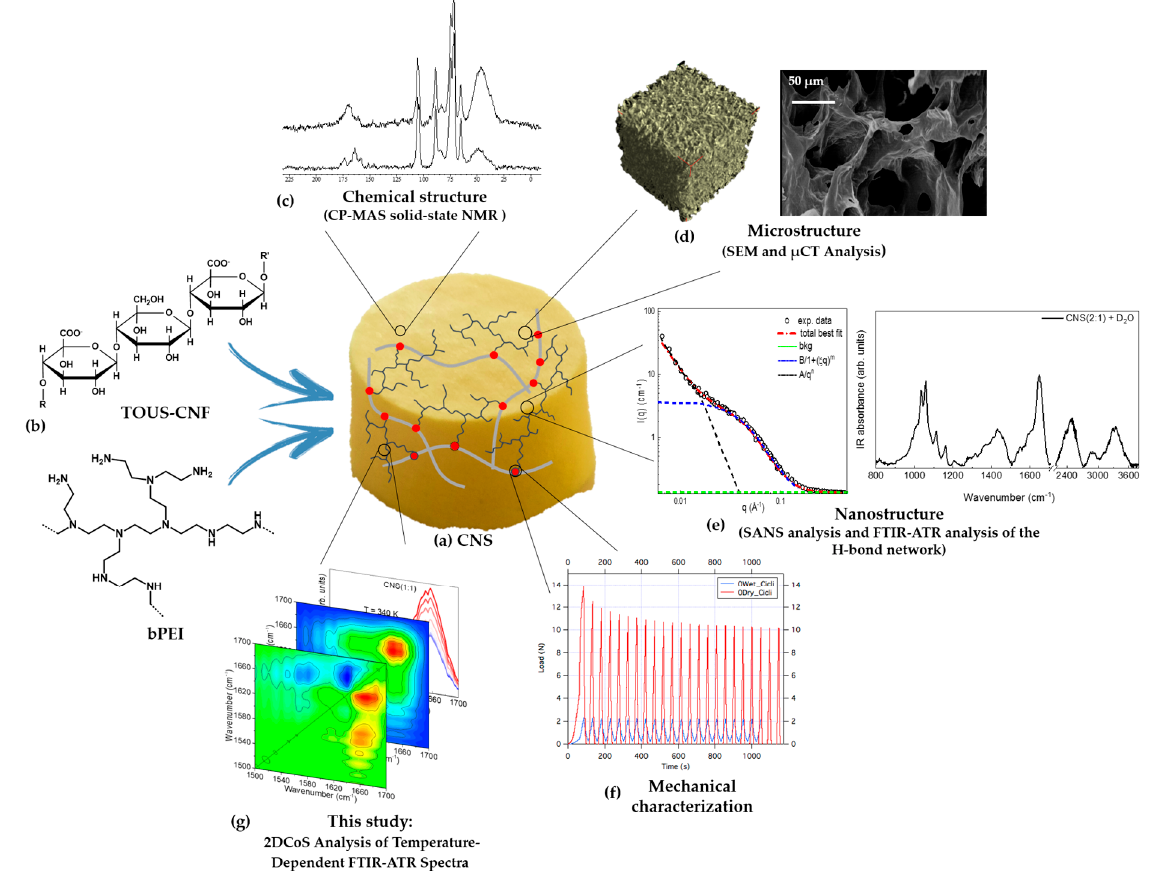
Figure 1. Schematic representation of cellulose nano-sponge (CNS) ( a ). Red dots represent the cross-link points between its polymeric constituents, i.e., TEMPO oxidized and ultra-sonicated cellulose nano-fibers (TOUS-CNFs) and branched polyethyleneimine (bPEI) (grey and black lines, respectively (see panel ( b )). A detailed characterization was performed, as far as chemical structure ( c ); microstructure ( d ); nanostructure and hydrogen bond (HB) arrangements ( e ); mechanical properties ( f ) are concerned. In this study, 2D Correlation Spectroscopy (2DCoS) Fourier transform infrared spectroscopy in attenuated total reflectance geometry (FTIR-ATR) analysis was exploited for evaluating the effects that temperature can exert on the dynamical properties of the CNS ( g ). See text for details.